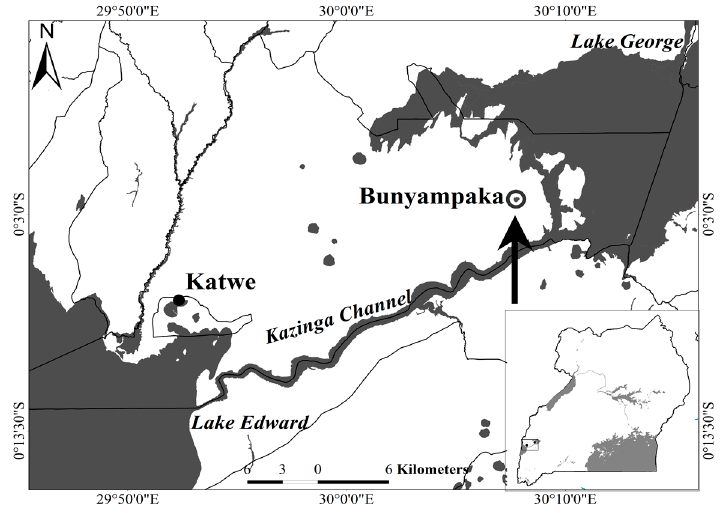
Figure 1. Detail map showing Lake Bunyampaka (left; see arrow) and its location in Uganda (inset bottom right). Table 1. Water analysis results for the Lake Bunyampaka sample used for Artemia culture tests. ICP-OES: inductively coupled plasma-optical emission spectrometer.